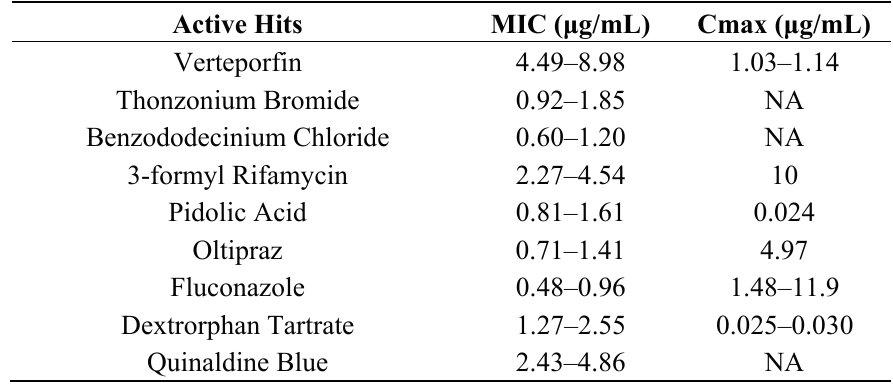
Table 2. Minimum inhibitory concentration values of some persister-active hits for B.